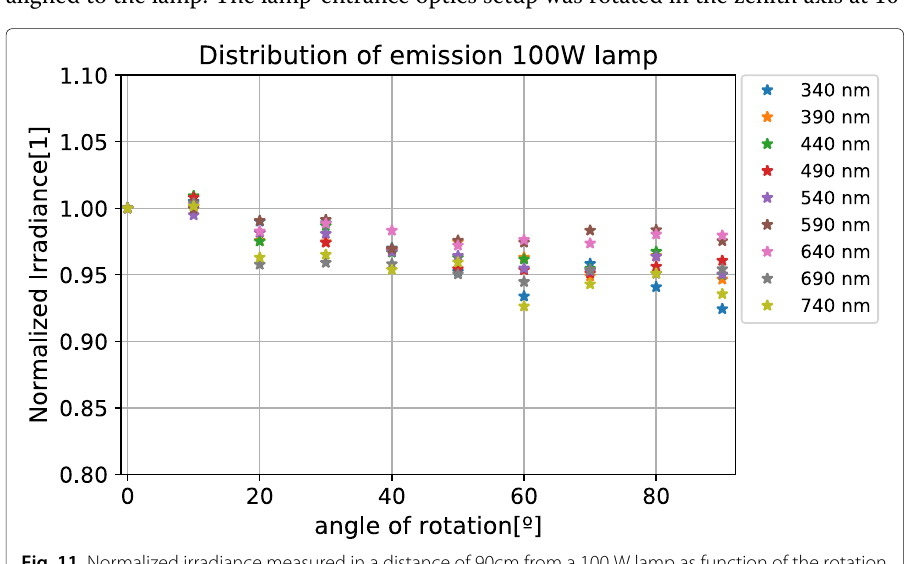
Fig. 11 Normalized irradiance measured in a distance of 90cm from a 100 W lamp as function of the rotation angle in the zenith. The radiant exitance of the lamp decreases up to 7% when it is rotated